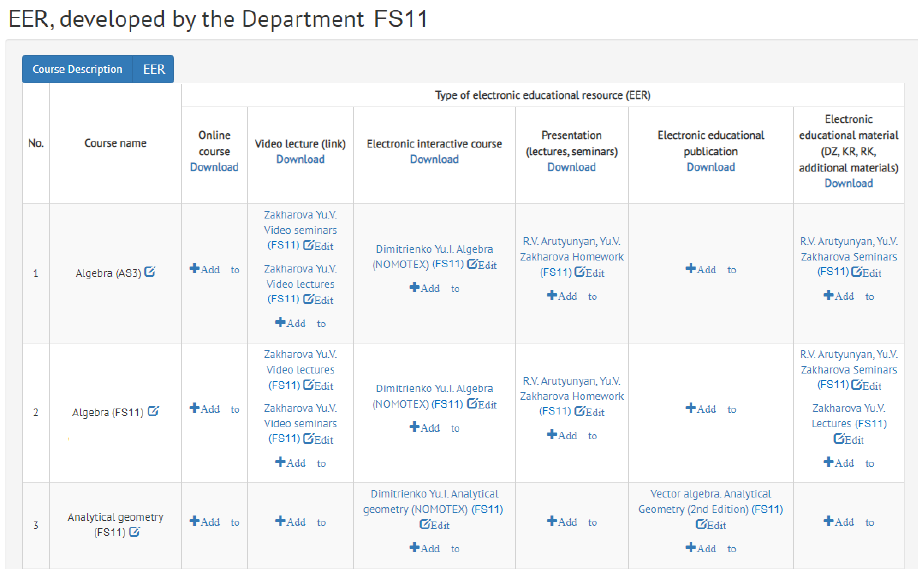
Fig. 3. Electronic Educational Resources (EER) storage system of the Open BMSTU